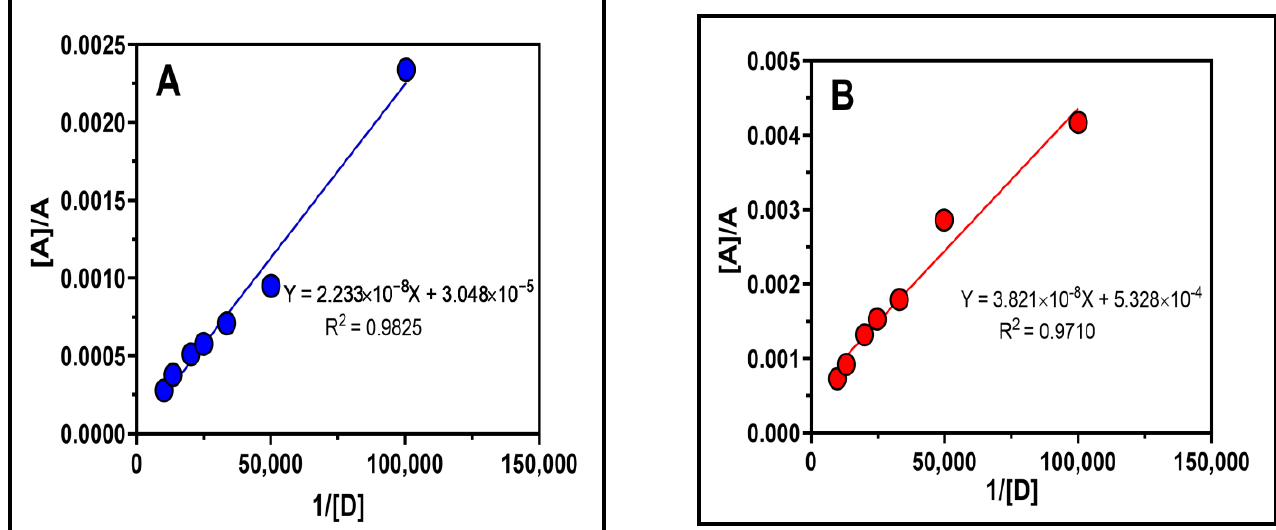
Figure 7. LGN complexes with ( A ) DDQ and ( B ) CHA are shown in this Benesi–Hildebrand plot. On the graph are presented the linear regression equation and the correlation coefficient (r). [A], A, and [D] denote, respectively, the molar concentrations of LGN, the absorbance’s of the complex reaction mixture, and the molar concentration of DDQ and